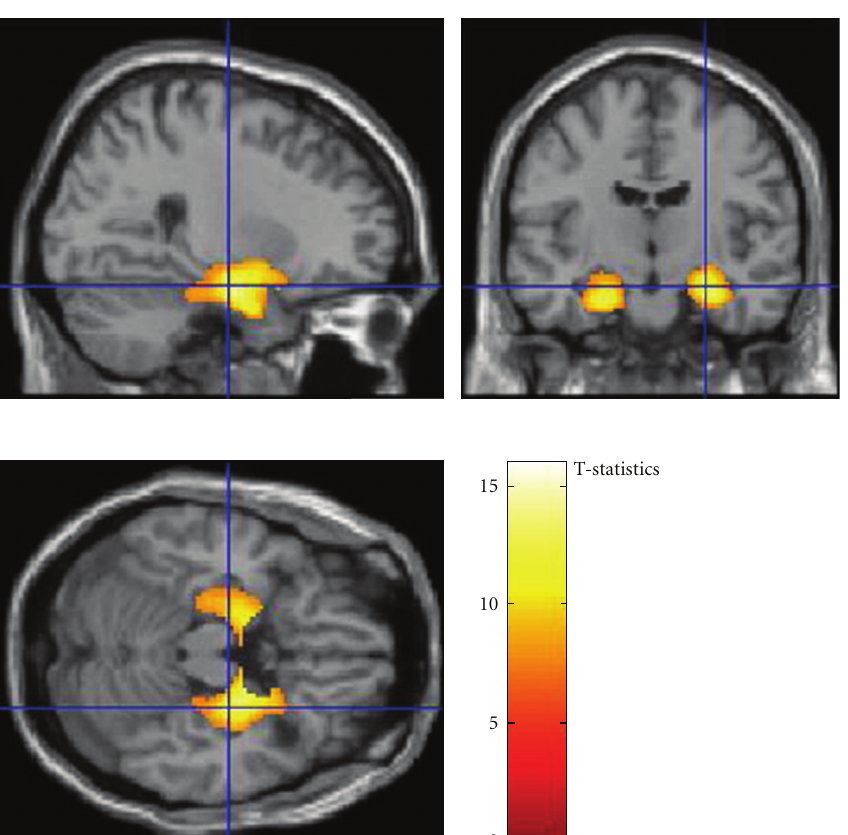
Figure 6: [F-18]FDDNP minus [C-11]PIB results (yellow blobs) in the same patients with AD as statistical parameter mapping (SPM) projections superimposed on a standardized magnetic resonance imaging brain template in the three orthogonal right sagittal (upper left), coronal (upper right), and axial (lower left) views ( P < . 05 (FWE); corrected, k = 100). Adapted and reprinted with permission from Shin et al. [25] [Copyright (2010)